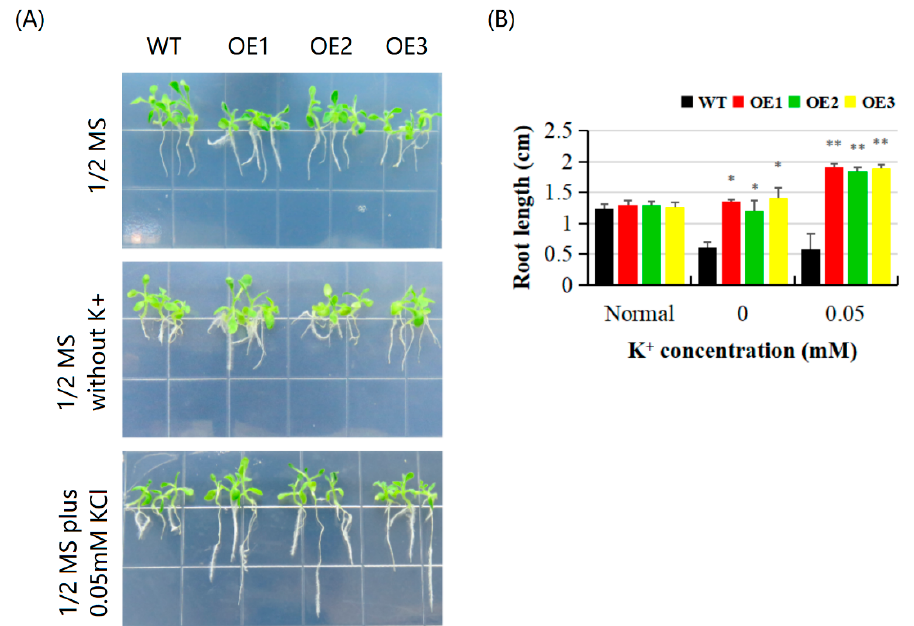
Figure 8. Seedling assay for potassium deficiency. ( A ): Phenotype differences in the seedling growth after 15 days treatment for potassium deficiency. WT: wild type tobacco; OE1~3: the MaCBL2 overexpressed transgenic tobacco. ( B ) Differences in root length of potassium deficiency treated tobacco seedlings. The error bar indicates the mean ± SD, (*) indicates the significant difference p ≤ 0.05, (**) indicates the significant difference p ≤ 0.01.